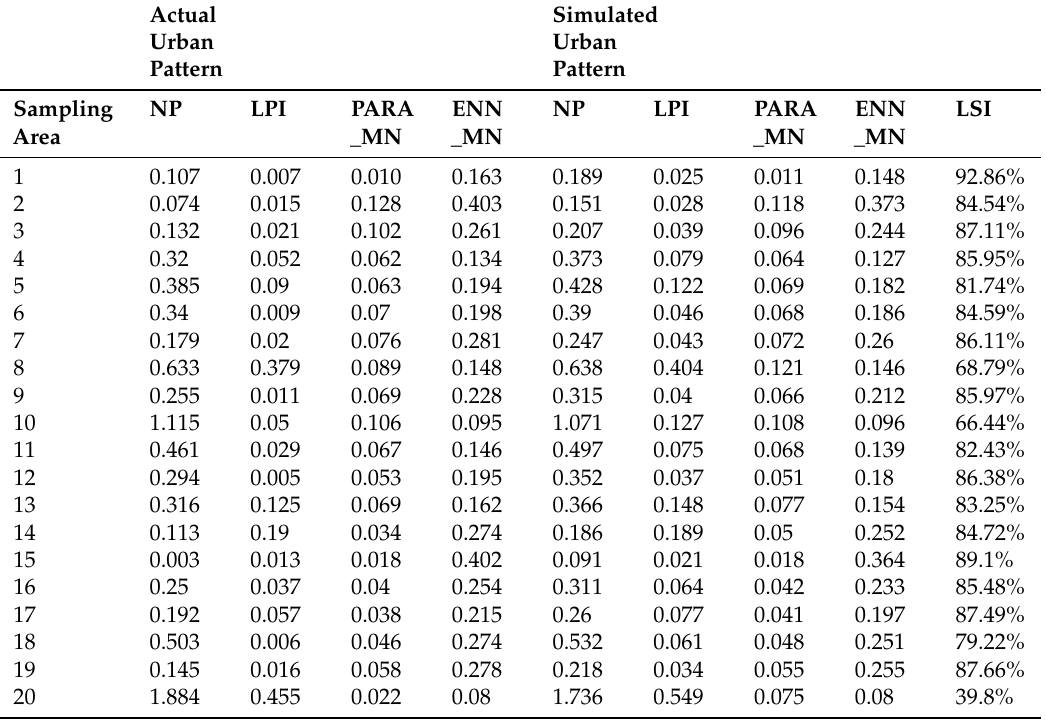
Table 3. Percent agreement between simulations (mean) and observed development based on the landscape similarity index (LSI), which evaluates the number of urban patches (NP); largest patch index (LPI); mean Euclidean nearest-neighbor distance (ENN _MN); and (4) mean perimeter–area ratio (PARA_MN). Low similarity is observed in only four sample areas (e.g., zones 8, 10, 18,